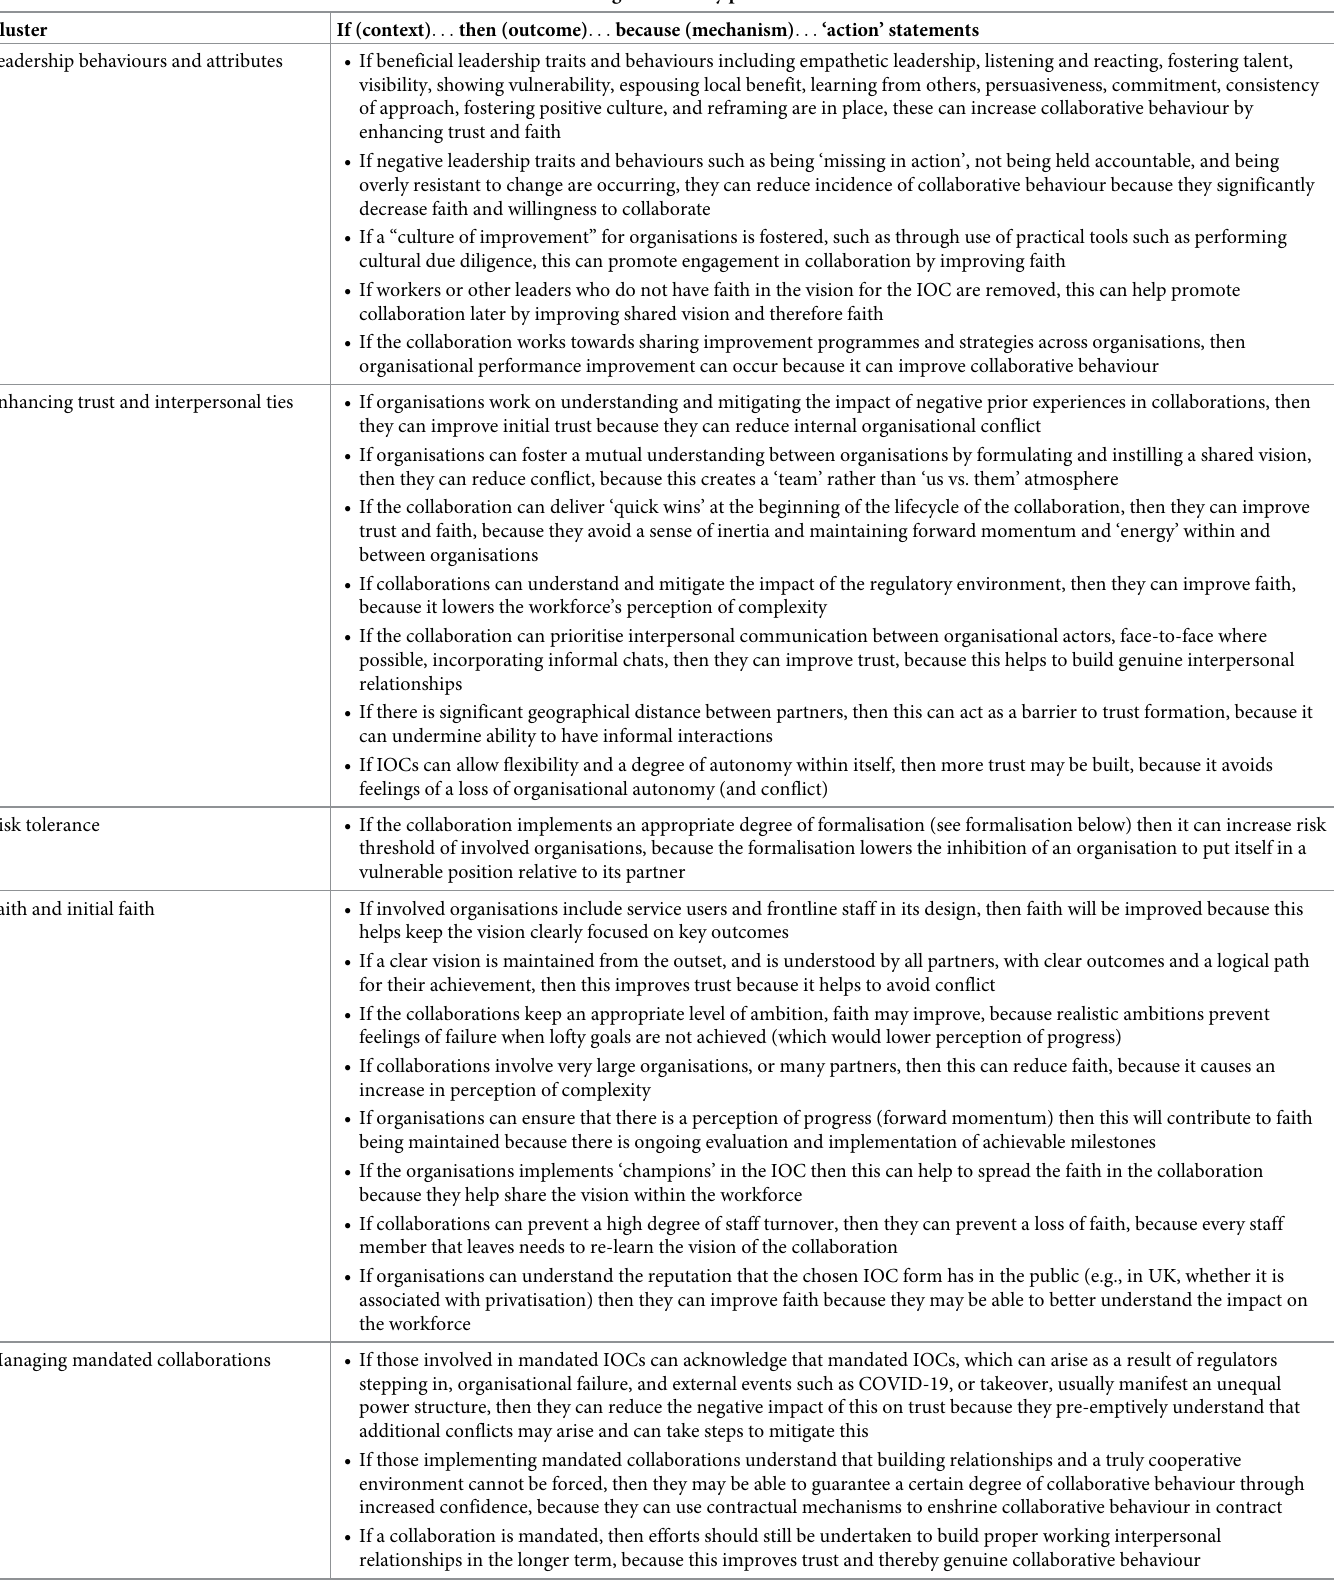
Table 3. Action statements about how to maximise collaborative functioning and thereby performance.